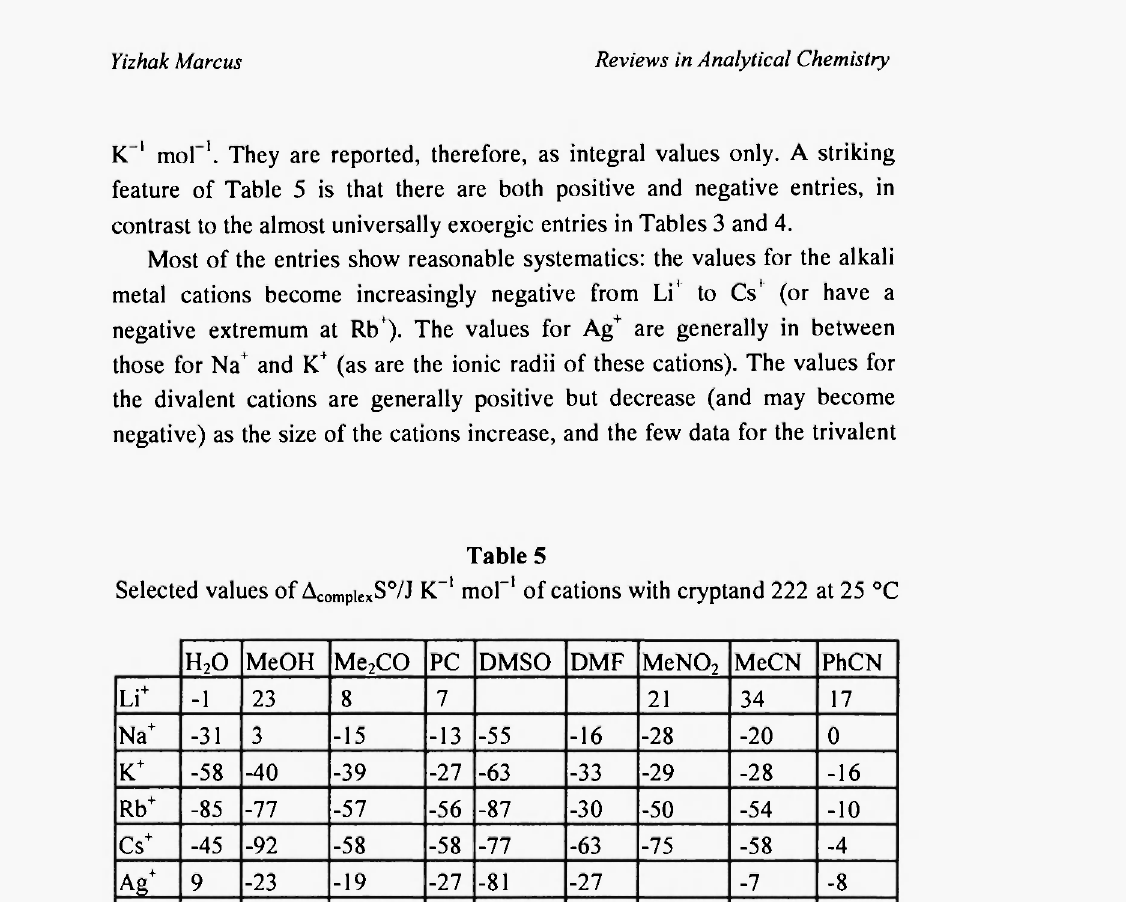
Selected values of A comp i ex S°/J ΚΓ 1 mol -1 of cations with cryptand 222 at 25